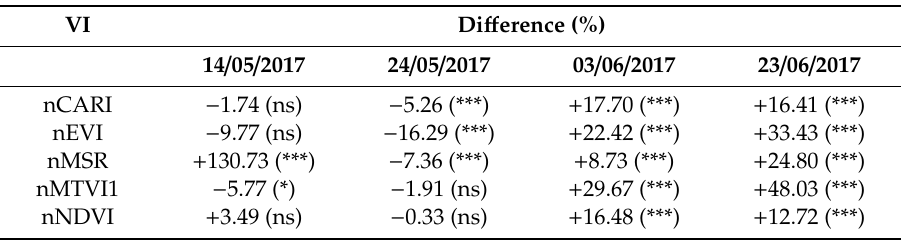
Figure 5. Change of normalized NDVI and MSR from May to June 2017. The values reported in y axis represent the reflectance values normalized on the first date, equating to 1. Statistical significance was determined by Student’s t -test. Single asterisk indicates a significant di ff erence between treatments, p < 0.05; double asterisk indicates a statistical di ff erence, p < 0.01; triple asterisk indicates a statistical di ff erence, p < 0.001 (unpaired t -test). Error bars represent standard error of the mean. Table 5. Di ff erences in the relative reflectance of the nVIs computed in F compared to NF. Single asterisk indicates a significant di ff erence, p < 0.05; double asterisk indicates a statistical di ff erence, p < 0.01; triple asterisk indicates a statistical di ff erence, p < 0.001 (unpaired t -test); ns indicates not significant di ff erence ( p > 0.05).